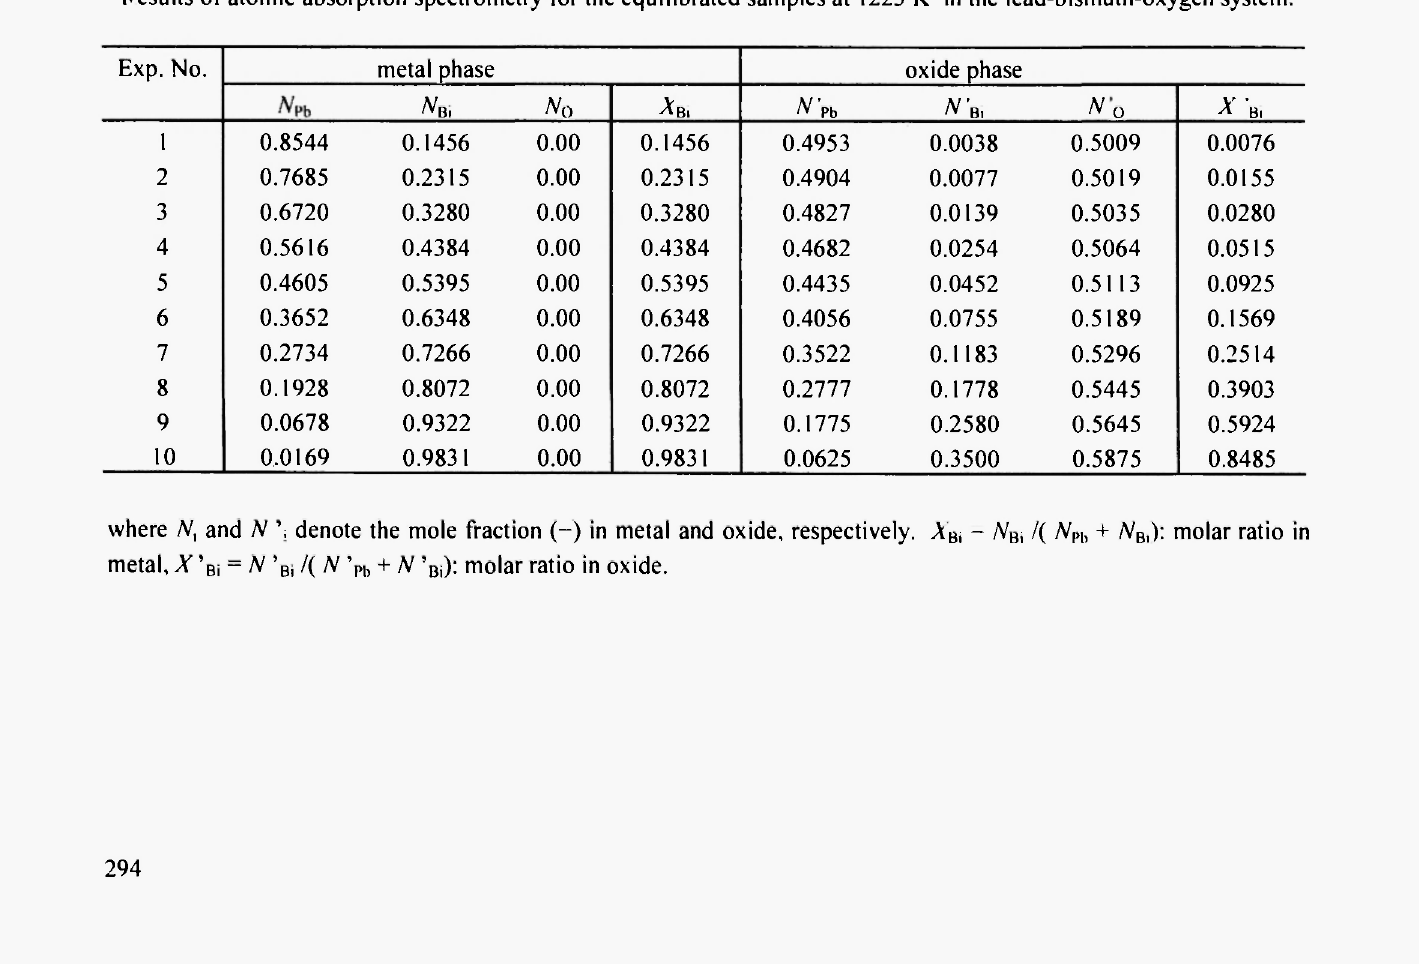
where N\ and Ν denote the mole fraction (-) in metal and oxide, respectively. -V Bi = N Bl /( /V Pb + N Bi ): molar ratio in